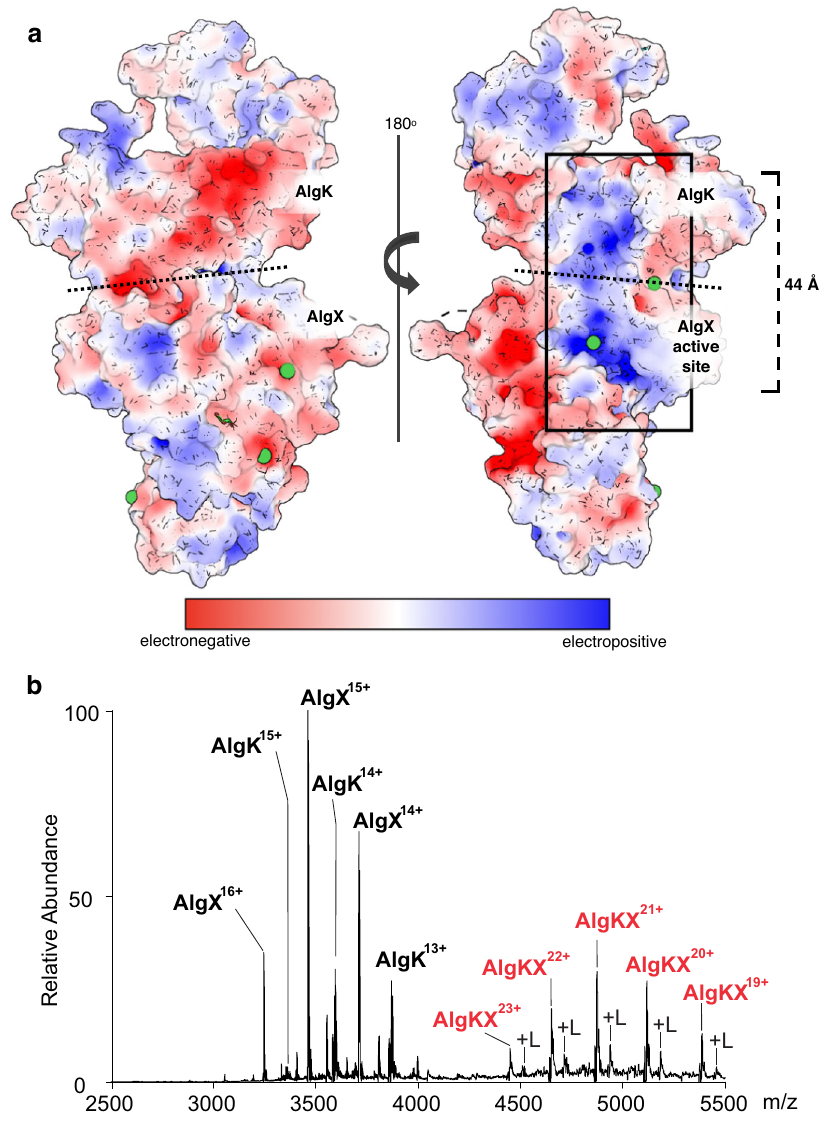
Fig. 3 | The AlgKX complex bindsalginate. a Electrostatic surface representation of the AlgKX Pp complex calculated by APBS Tools; contoured from +5 (blue) to − 5 (red) kT/e. The box highlights the proposed pathway from the site of alginate acetylation by AlgX Pp towards alginate export via AlgK Pp . The dashed bracket represents the distance of the proposed pathway. Dotted black lines represent the